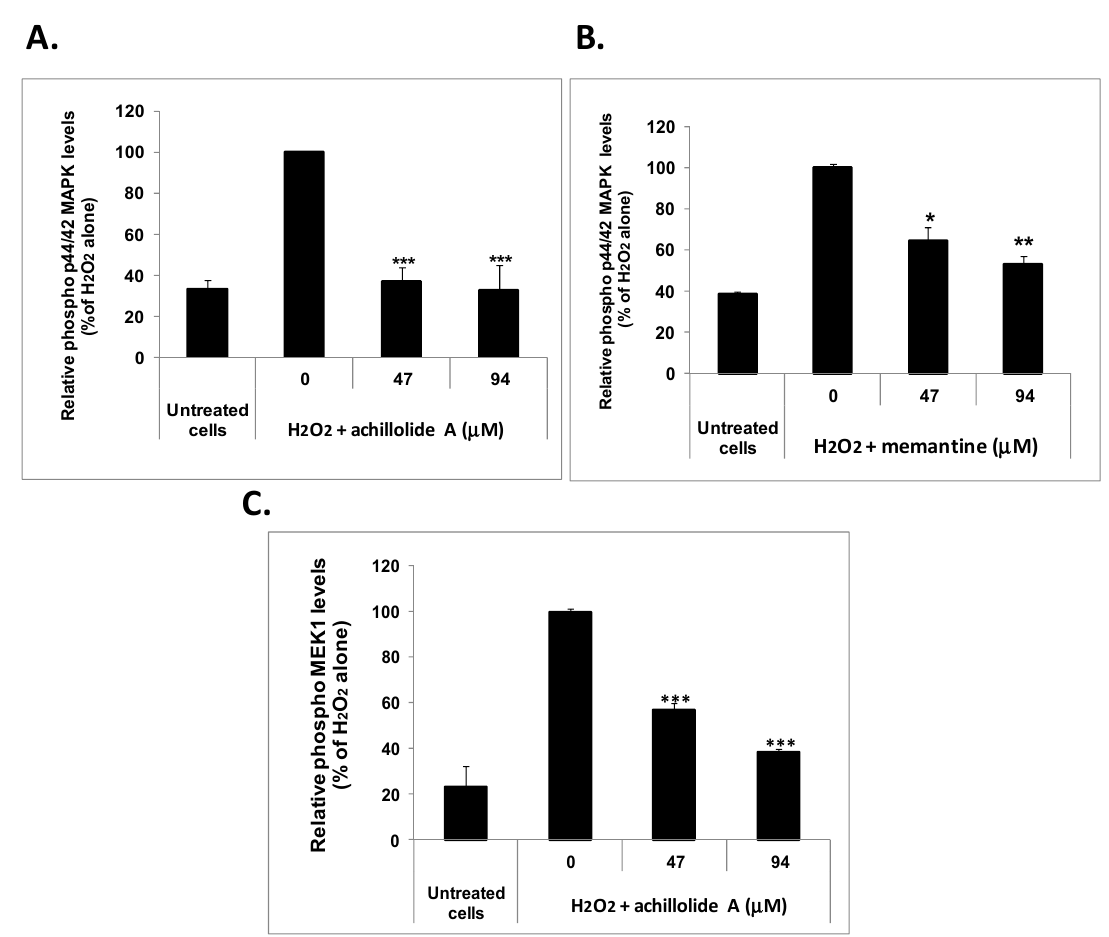
Figure 3. Inhibitory effect of achillolide A on H 2 O 2 -induced phosphorylation of p44/42 MAPK and MEK1 in astrocytes. Astrocytes were treated with 175 μ M of H 2 O 2 for 40 min following preincubation with achillolide A or memantine for 2 h. The levels of phosphorylated and total p44/42 MAPK ( A , B ) and phosphorylated and total MEK1 ( C ) were measured by ELISA. Relative phospho MAPK levels were calculated from the ratio: phospho MAPK levels/total MAPK levels the results are means ± SEM of two experiments ( n = 4). * p < 0.05; ** p < 0.01; *** p < 0.001.